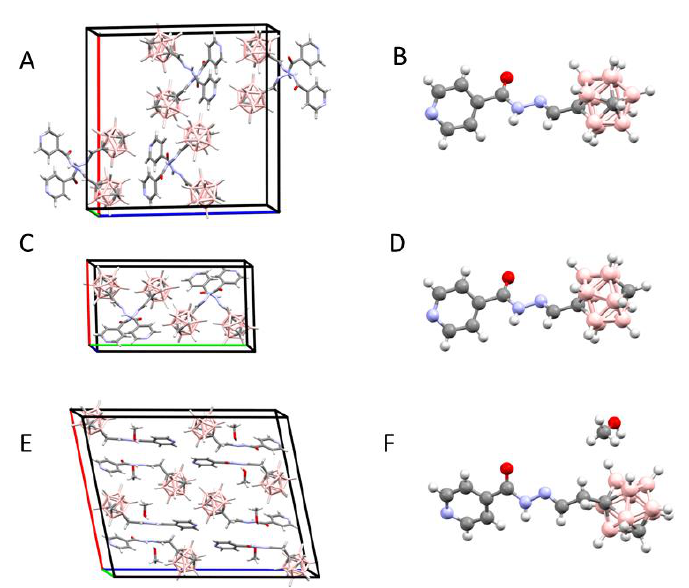
Figure 4. The crystallographic structures of INH–carborane hybrids: crystal packing and molecular structure of 14 ( A , B ), 15 ( C , D ), and 21 ( E , F ).